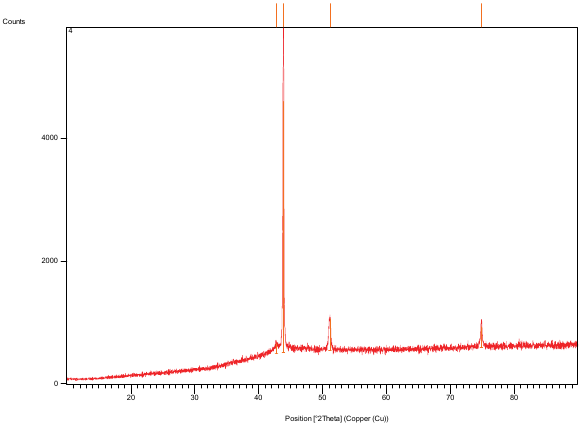
Fig. 6. The changes of dielectric elements on the work surface XRD phase pattern analysis of identified phases Ref.